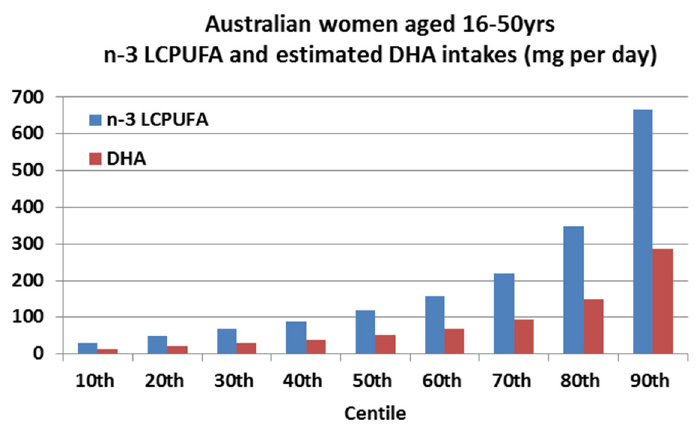
Figure 2. Australian women’s consumption of n ‐ 3 LCPUFA and the respective estimated docosahexaenoic acid (DHA) (mg per day) per centile.